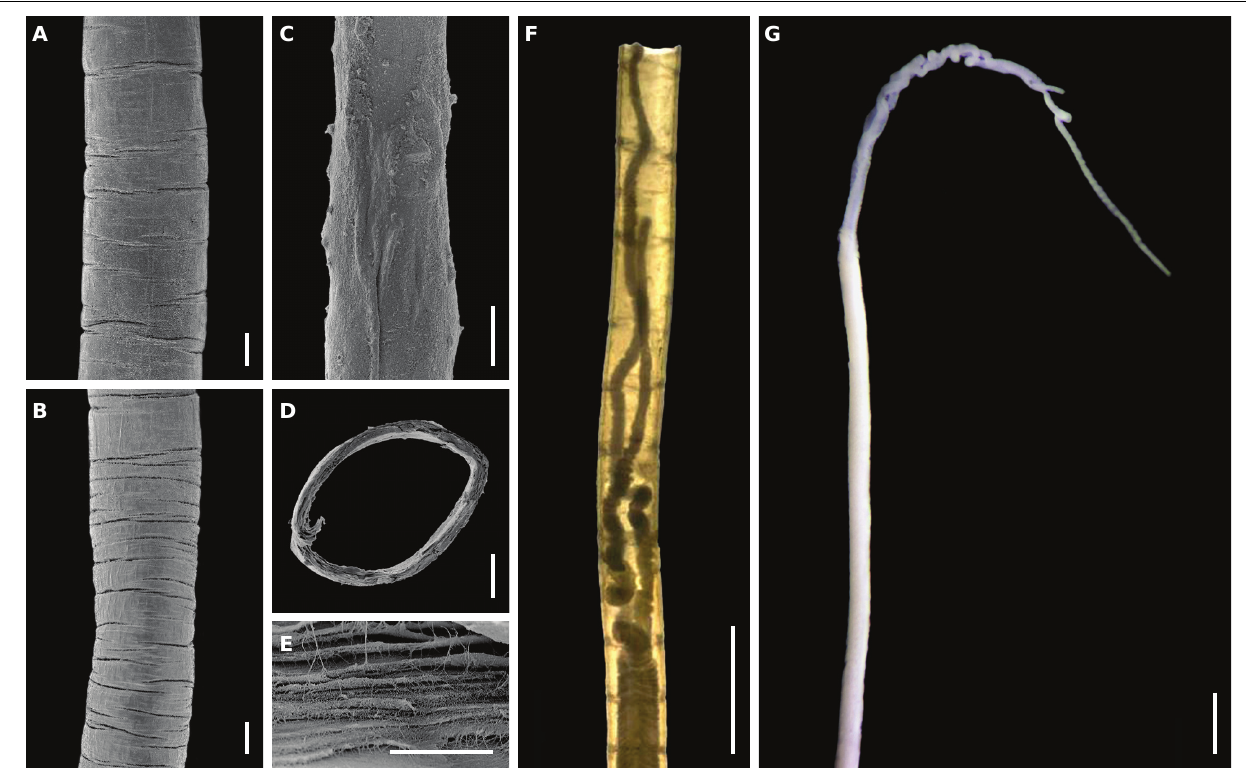
FIGURE 3 | Tube and overall features of Sclerolinum annulatus n. sp. (A) Scanning electron microscopy (SEM) of the anterior region of the tube with sparser transverse rings (holotype TMBC030854). (B) SEM of the middle region of the tube with denser transverse rings (holotype TMBC030854). (C) SEM of the posterior region of the tube, which is rather smooth with no transverse rings (holotype TMBC030854). (D) SEM of the cross section of the tube (holotype TMBC030854). (E) SEM of a close-up section of the tube, showing the multi-layered and fibrous structure (paratype TMBC030855). (F) Light micrograph, showing the sparser transverse rings on the anterior region of the tube and two tentacles of the tubeworm (paratype TMBC030856). (G) Light micrograph in lateral view, showing two tentacles and the forepart. Scale bars: (A–D) 100 µ m; (E) 10 µ m; (F,G) 1